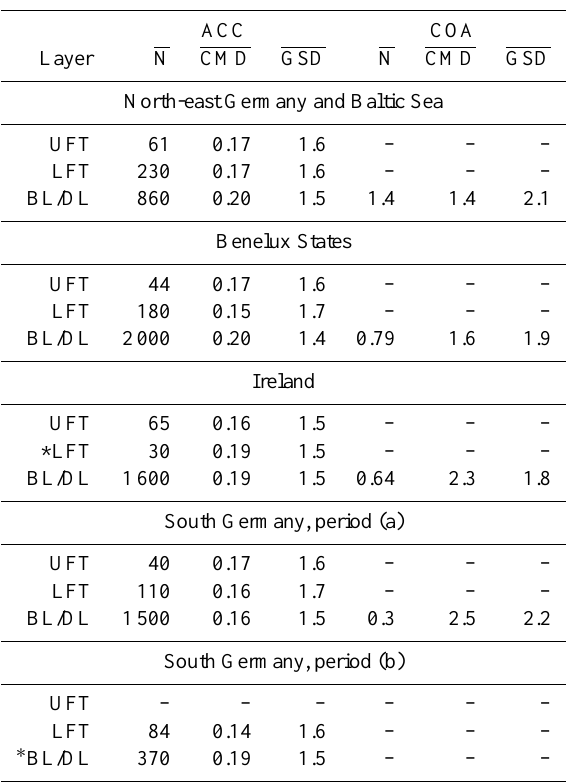
Table 4. Modal fitting parameter for size distributions selected by regions and vertical levels. The corresponding size distributions are shown in Fig. 6. Average number concentrations N are given inparticlescm − 3 at standard temperature and pressure and average count median diameter CMD in µm.